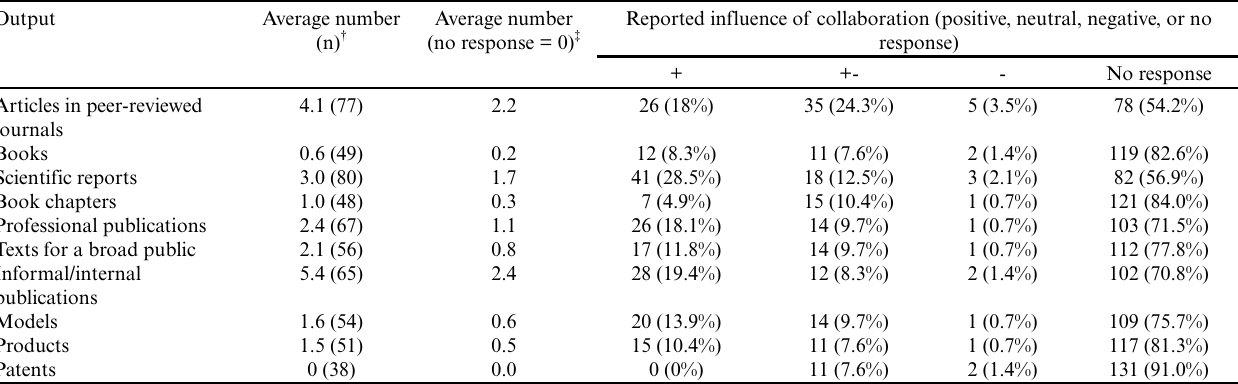
Table 6 . Output of joint knowledge production (JKP) projects and reported influence of collaboration with policy and practice. Output Average number Average number Reported influence of collaboration (positive, neutral, negative, or no (n) † (no response = 0) ‡ response) + +-